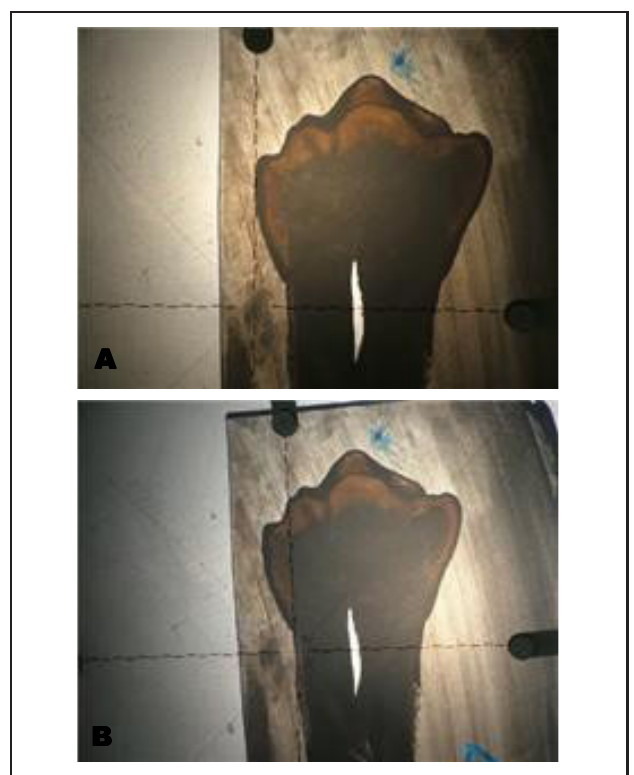
BBBBB Fig. 5 – Projected image on the profilometer for measuring enamel thickness (A and B).